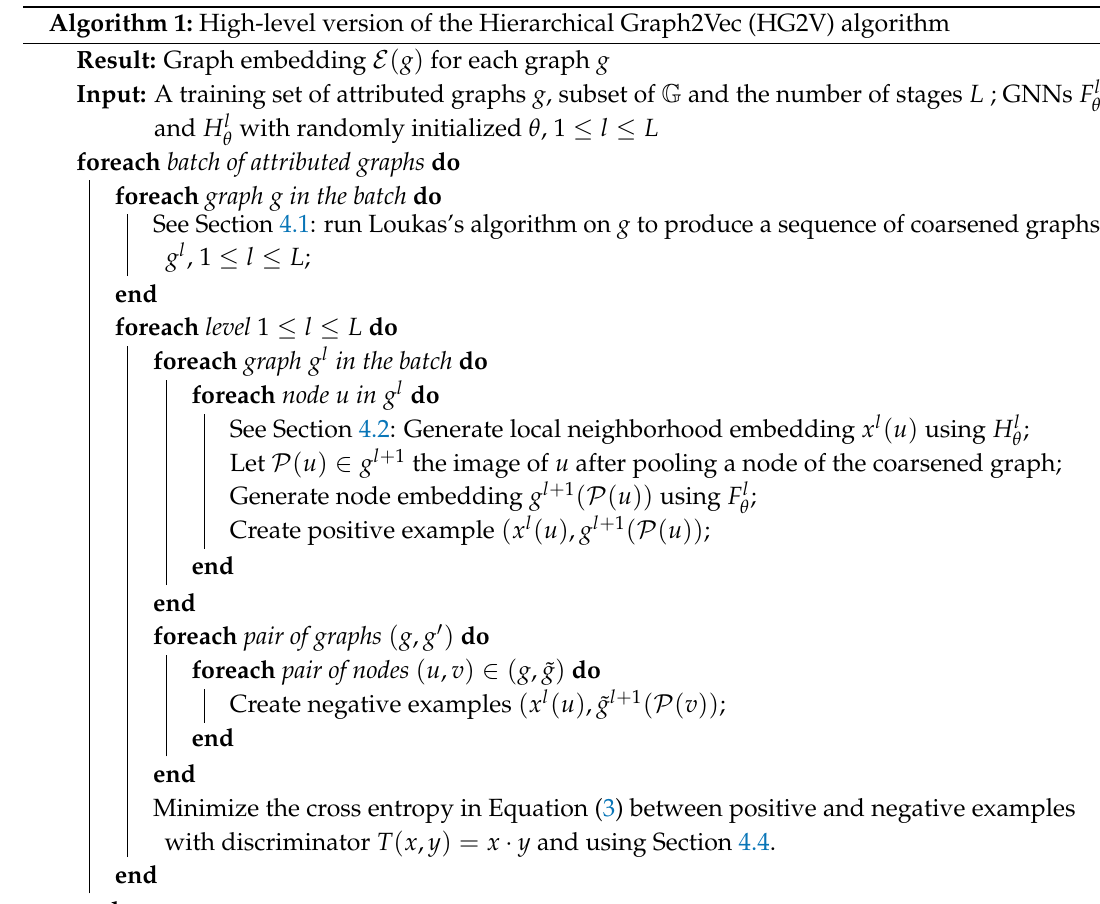
Algorithm 1: High-level version of the Hierarchical Graph2Vec (HG2V) algorithm Result: Graph embedding E ( g ) for each graph